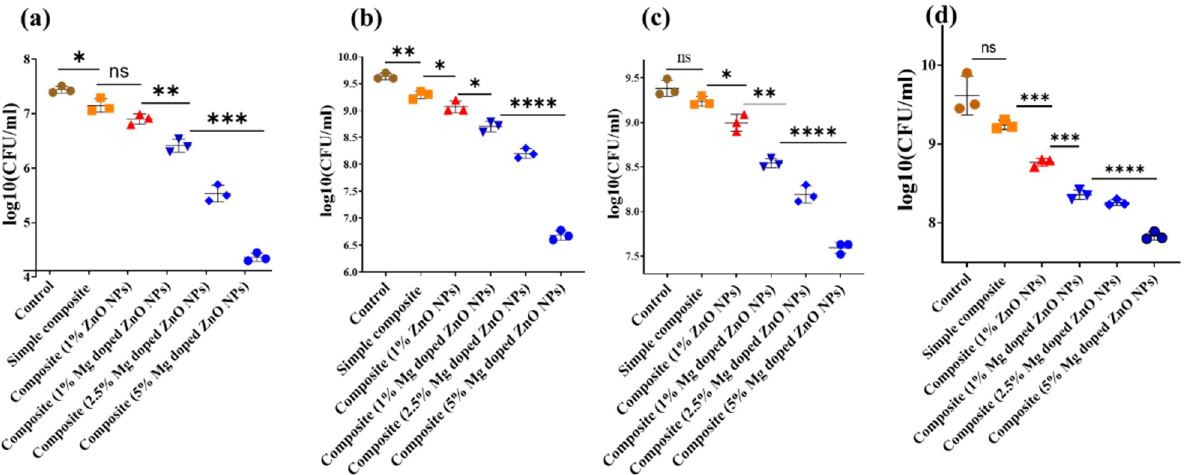
Figure 4. Antibacterial effect of composites with bare and Mg-doped ZnO NPs against ( a ) S. mutans , ( b ) E. faecalis , ( c ) saliva-derived microcosm, and ( d ) diabetic microcosm. p -value < 0.05 is flagged with one star (*), while (**) means p -value < 0.01, (***) represents a p -value < 0.001 and (****) shows p value <0.0001. ns (not significant) represents statistically insignificance.